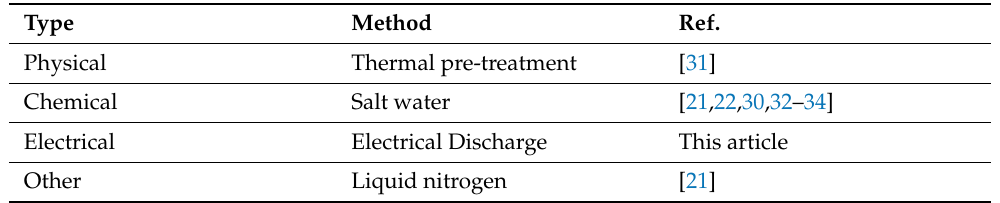
Table 1. Discharge methods for